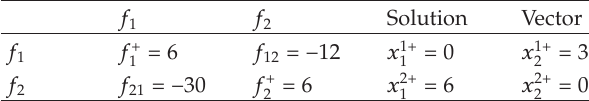
Table 3: First pay-o ff table of Section